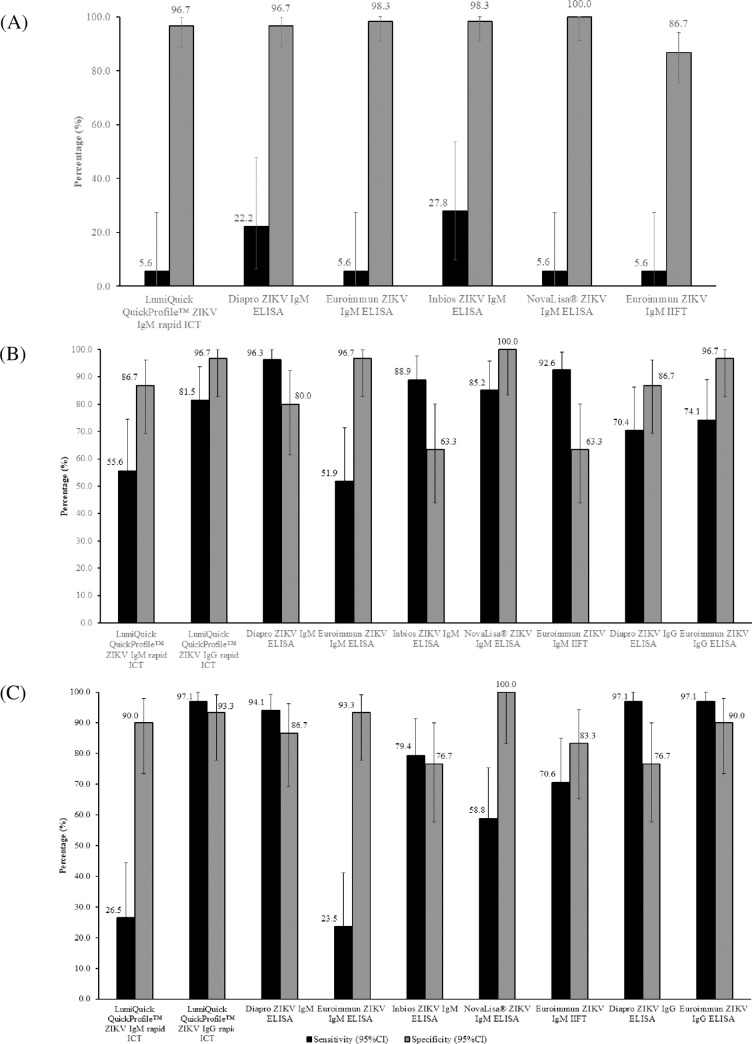
(A) Sensitivity and specificity of ZIKV IgM rapid ICT, ELISAs and IIFT using acute samples from ZIKV-confirmed, DENV-confirmed, and non-ZIKV and non-DENV patients (Set A; n = 78). Sensitivity and specificity of ZIKV IgM/IgG rapid ICT, IgM ELISAs/IIFT and IgG ELISAs using (B) 7–14 days’ (Set B1; n = 57) and (C) 23–34 days’ (Set B2; n = 64) convalescent samples from ZIKV-confirmed, DENV-confirmed, and non-DENV patients. Confidence intervals (black bars) were constructed using Wald’s method.